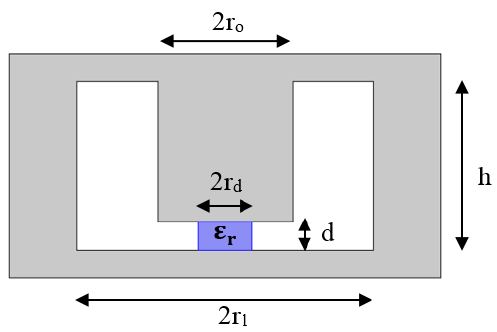
Figure 3. Re-entrant cavity with a gap partially filled with a dielectric.